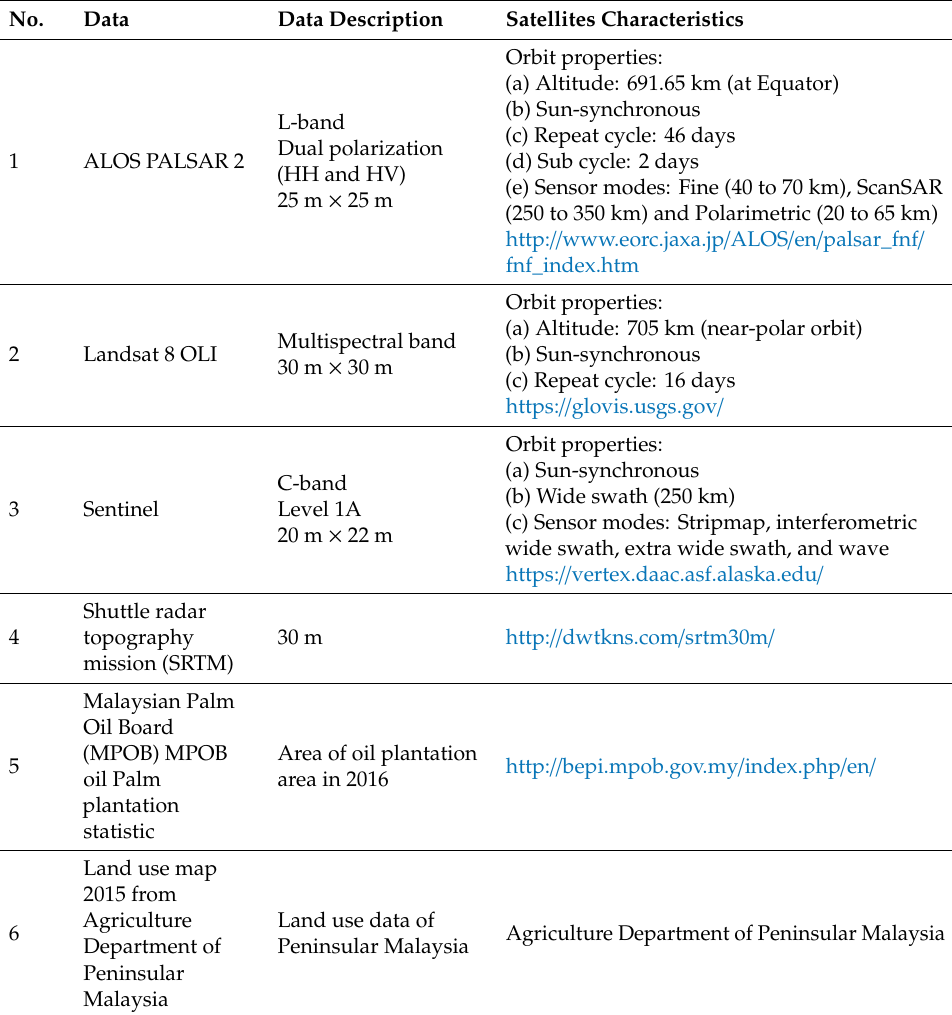
Table 1. Specifications of datasets used in the